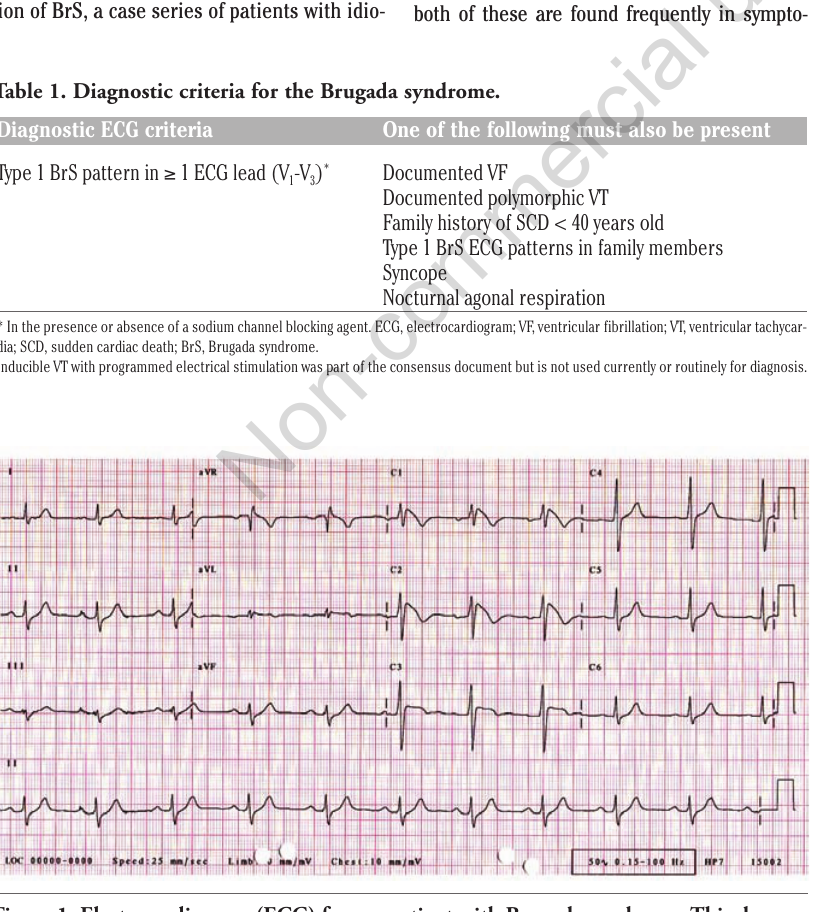
Figure 1. Electrocardiogram (ECG) from a patient with Brugada syndrome. This demon- strates the characteristic type 1 Brugada ECG pattern in leads V1 and V2 and a type 2 Brugada ECG pattern in lead V3.